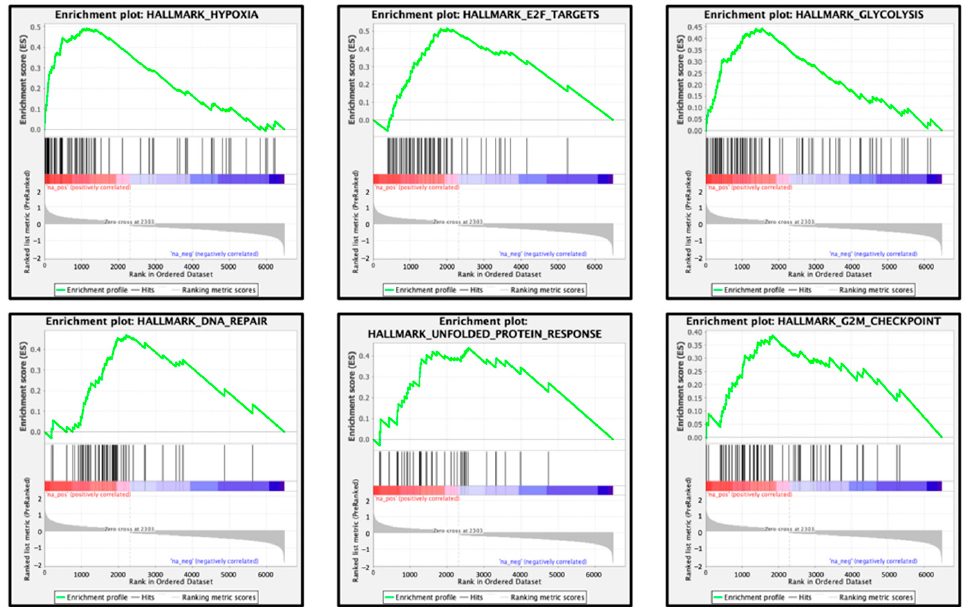
Figure 13. Pathways enriched among the differentially expressed genes in the high FOXD1 expression group according to gene set enrichment analysis. The nine significantly enriched pathways (top 9) are shown. Most enriched pathway was “Epithelial Mesenchymal Transition”.